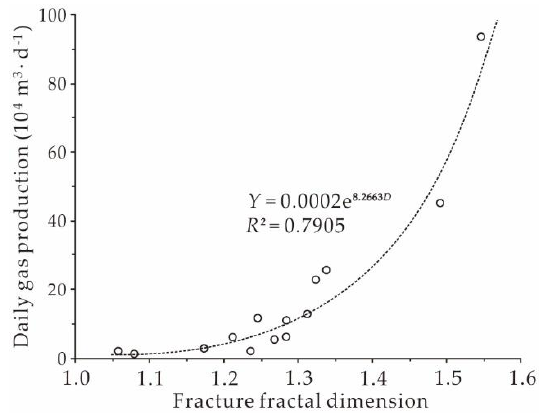
Figure 14. Relationship between fracture fractal dimension and well productivity.